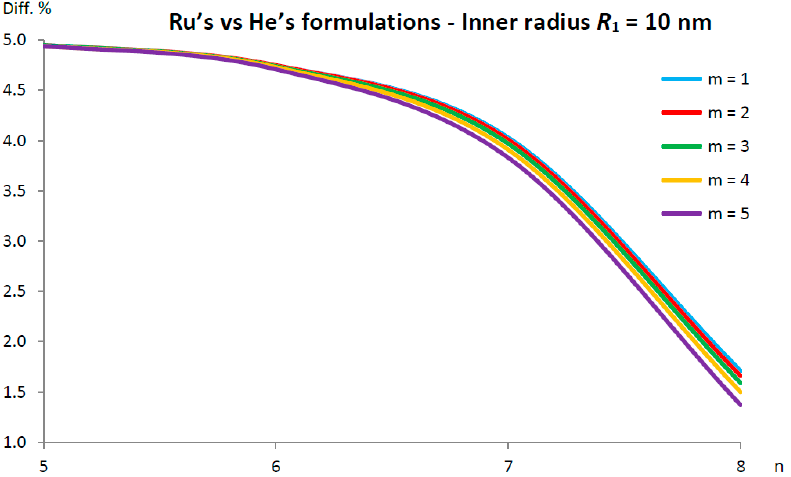
Figure 8. Percentage differences between the highest radial natural frequencies of the simply sup- ported DWCNT of Table 1 with inner radius R 1 = 10 nm and aspect ratio L / R 2 = 10 from Ru’s (38) and He’s (39) formulations. Donnell shell theory. Anisotropic elastic shell model. Number of longitudinal half-waves m . Number of circumferential waves n.